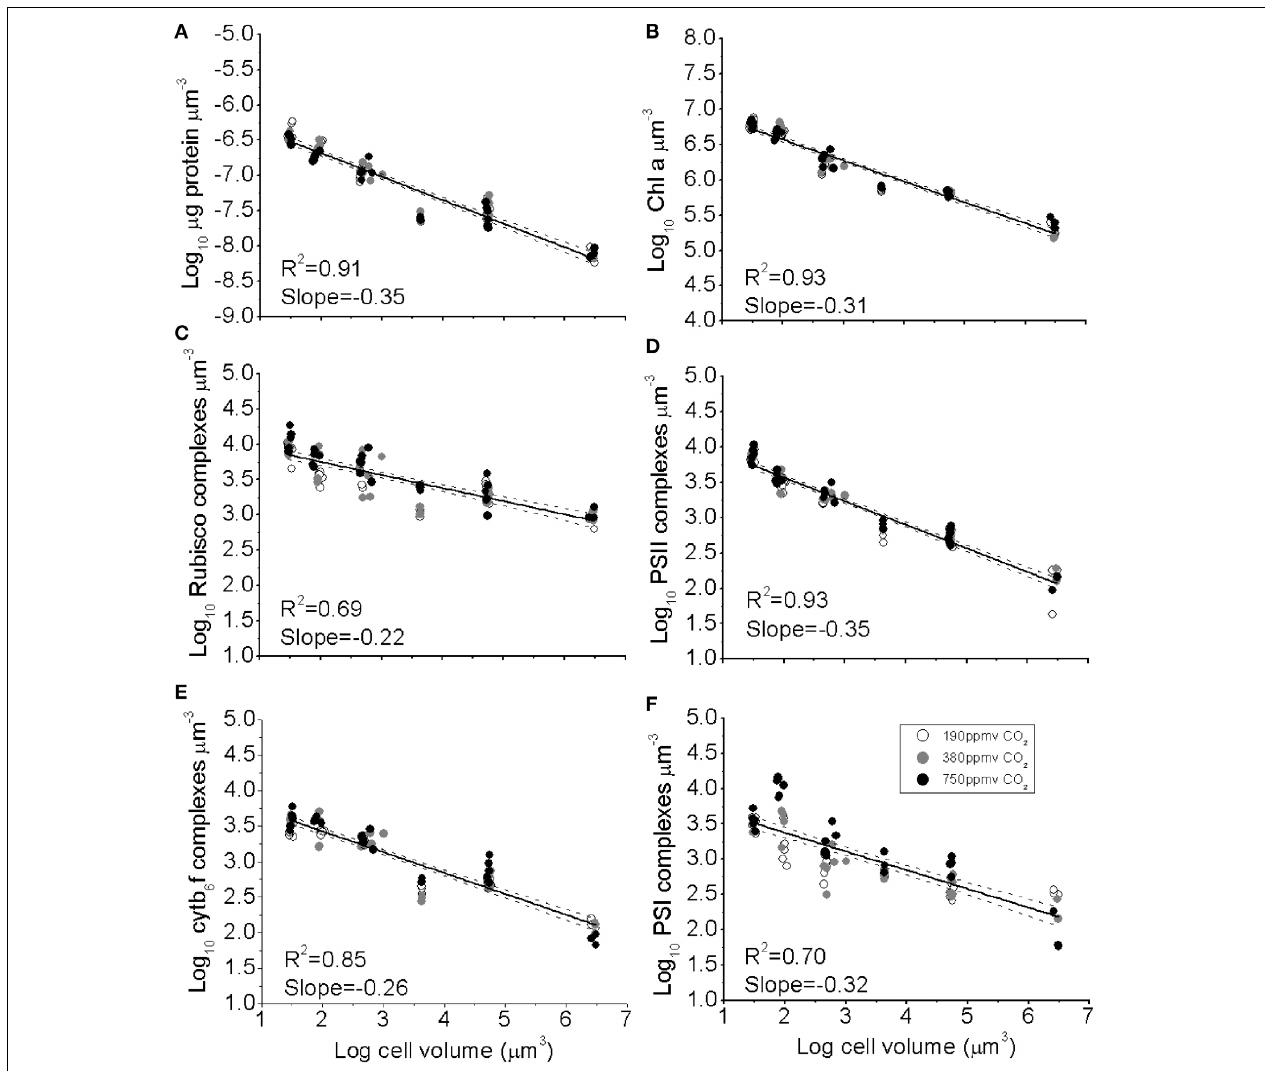
FIGURE 1 | (A) The log 10 of cellular concentration of total protein, (B) Chl a, (C) RUBISCO complexes, (D) Photosystem II complexes, (E) Cytb 6 f complexes, and (F) Photosystem I complexes plotted as functions of log 10 cell volume. Cultures were grown under p CO 2 190 ppmv (open symbols);